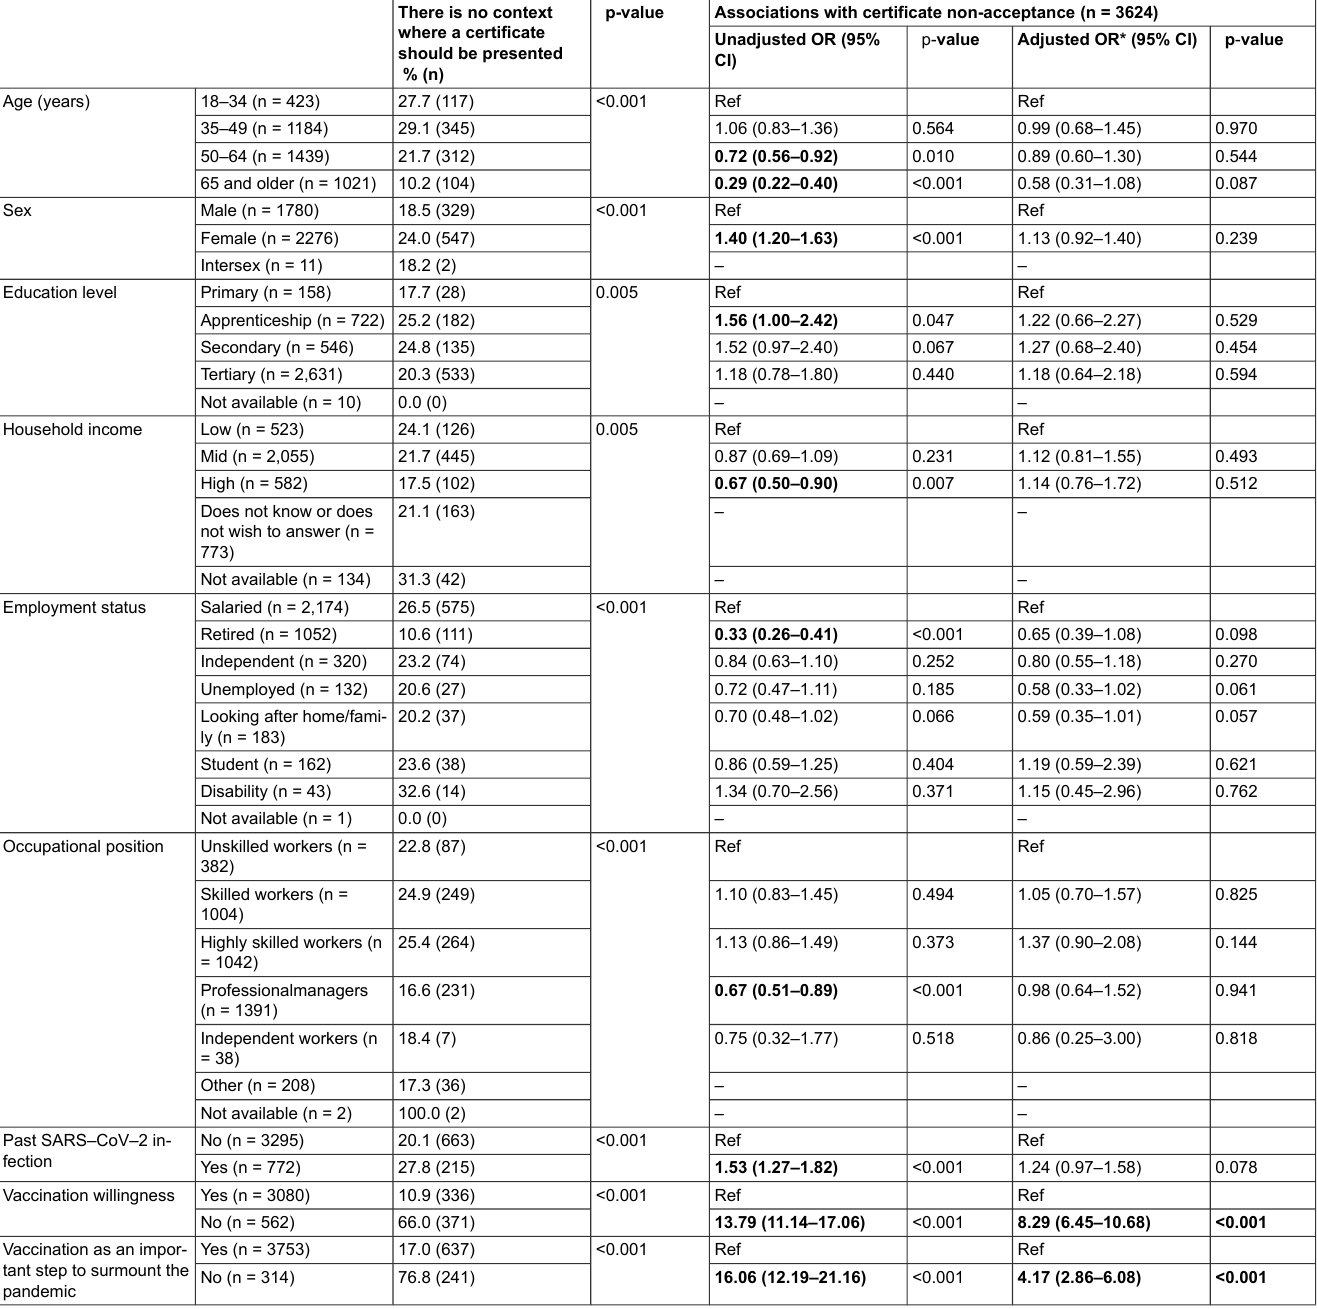
Table 3: Associations between baseline characteristics, past SARS-CoV-2 infection, perception and willingness to get vaccinated and certificate non-acceptance. Certificate non-accep- tance is defined as the outcome based on the answers to the question “There is no context where a certificate should be presented”. Observations where information was not available or with low numbers were not included in this